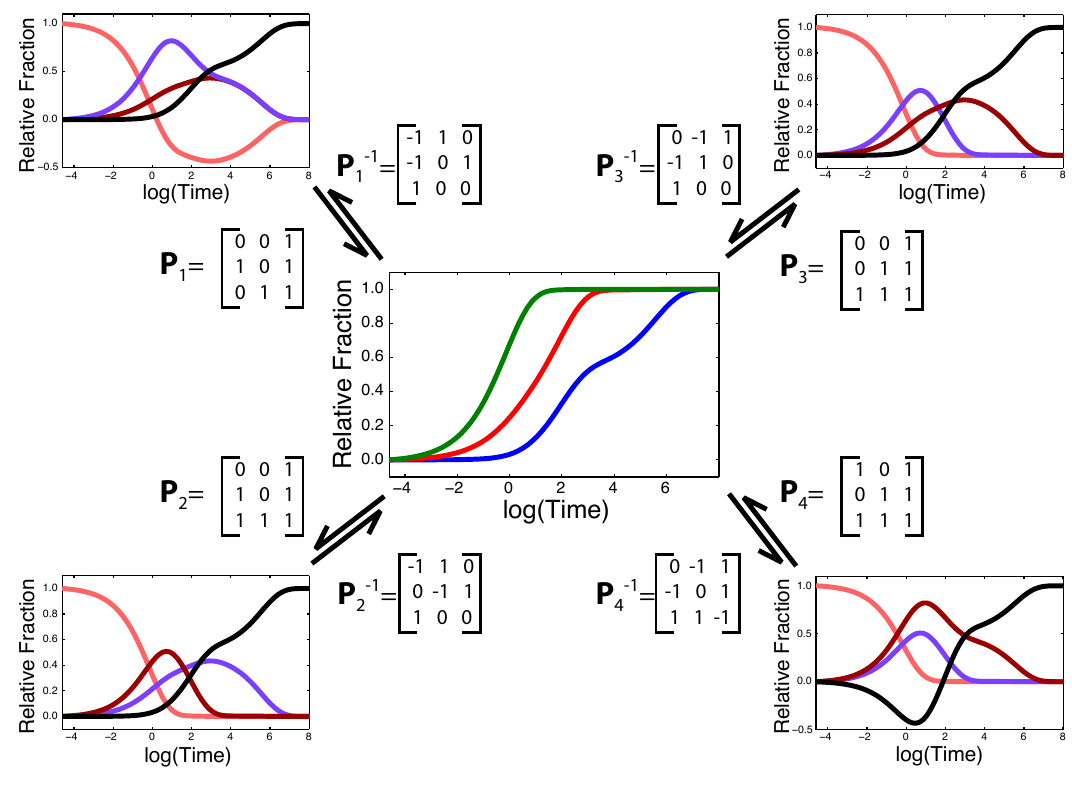
Figure 3. Illustration of the application of Equation 9 to (cid:126) C possible (cid:126)x ( t ) state curves (external panels); colors are identical to those used in Figure 1. Both P − 1 and P − 1 matrices generate negative state curves allowing us to eliminate them 1 4 without the need to optimize K with non-linear least squares. P − 1 curve shapes, but I 1 and I 2 are inverted. In this case, these two matrices yield degenerate models that are in fact equivalent, such that a single kinetic model describes the RNA folding